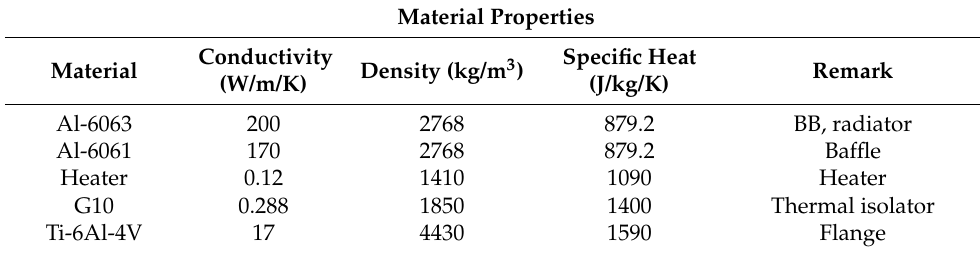
Table 3. Material and thermo–optical